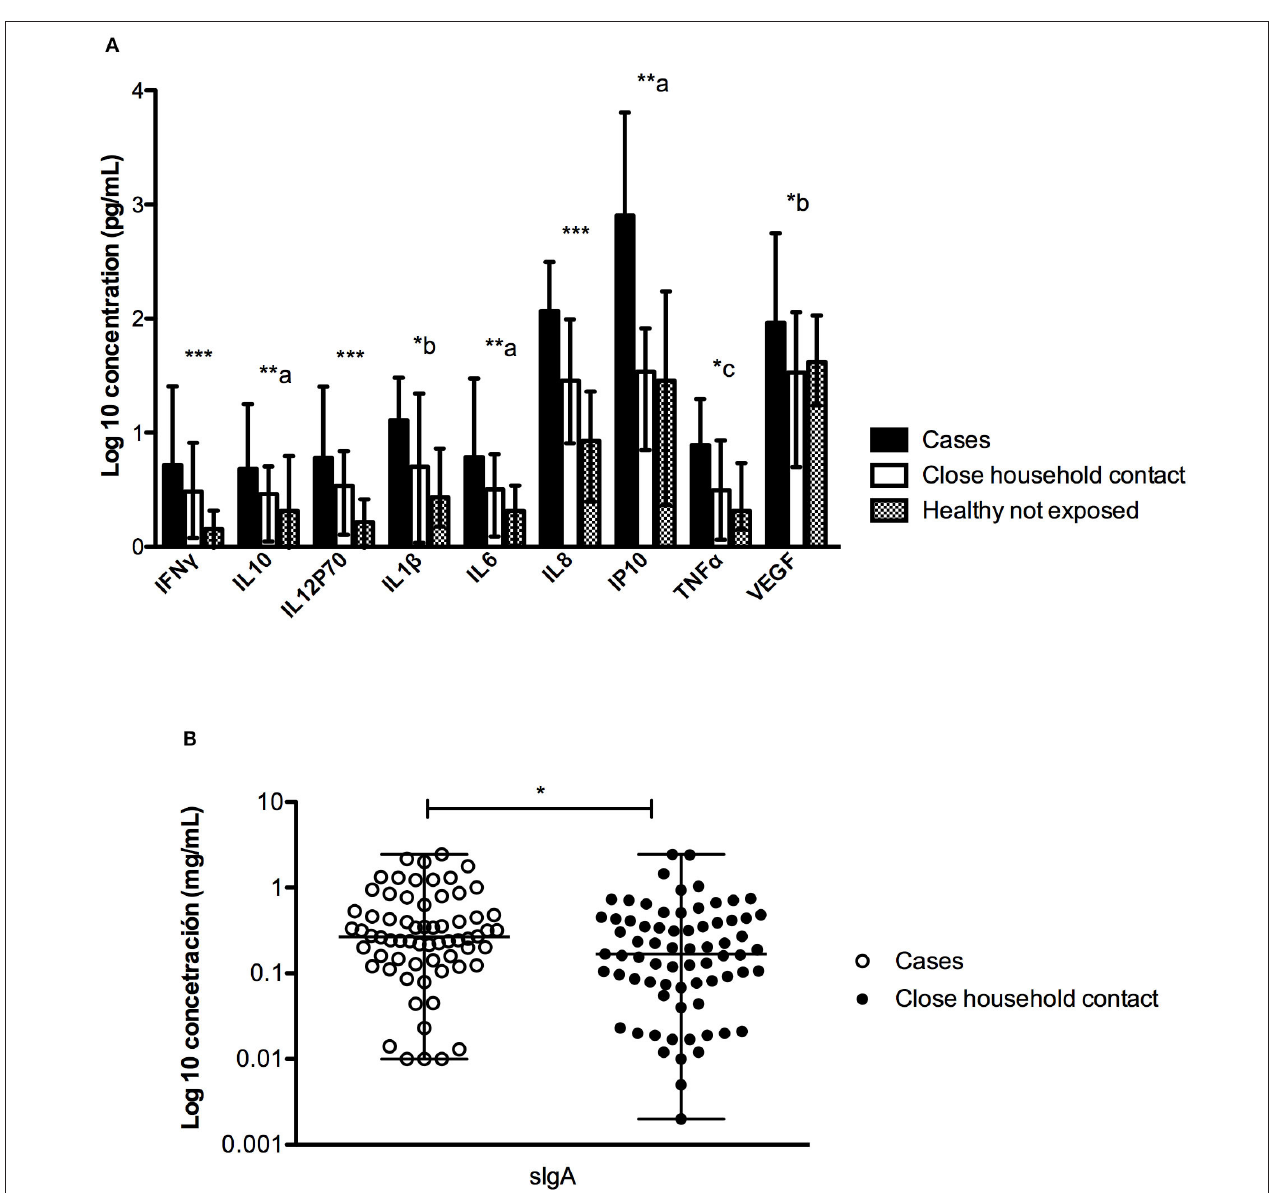
FIGURE 1 | Comparison of the concentration (pg/mL) of different factors measured in saliva between ANDV-infected cases, close household contacts and healthy controls not exposed. (A) Quantification (pg/mL) of INF γ , IL10, IL12p70, IL1 β , IL6, IL8, IP10, TNF α , and VEGF in all groups; dark boxes represent ANDV-infected cases, clear boxes represent close household contacts, and gray boxes represent healthy controls not exposed; Boxes represent median values and bars interquartile range. Comparisons are significance between columns: ***All group are statistically significant, **a: all group are statistically significant, except for Healthy controls not exposed and Close household contact, *b: only between Cases and Healthy controls not exposed is statistically significant, *c: only between Cases and Close household contact is statistically significant (Kruskal-Wallis test and Mann Whitney test, p < 0.05 = significant). (B) Quantification (mg/mL) of sIgA in first two groups; clear circles represent ANDV-infected case and dark circles represent close household contacts; whiskers represent minimum and maximum values and horizontal bar in the box the median value. * p < 0.05 (Mann Whitney